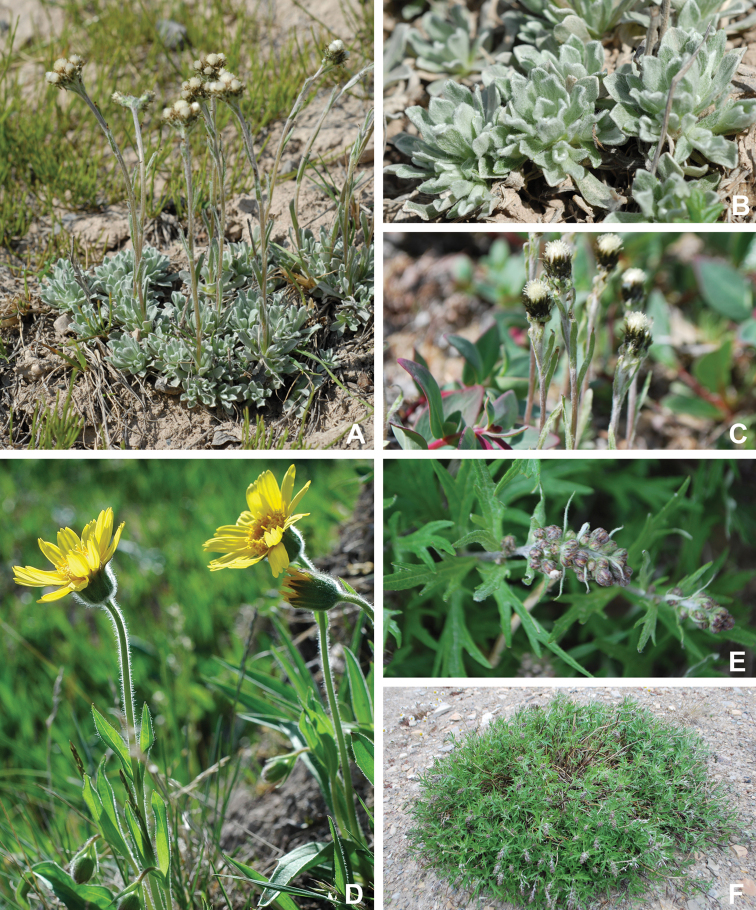
AAntennaria
media
subsp.
compacta habit, Gillespie et al. 9622BAntennaria
media
subsp.
compacta basal rosettes, Gillespie et al. 9622CAntennaria
monocephala
subsp.
angustata inflorescences DArnica
angustifolia
subsp.
angustifolia habit, Gillespie et al. 9607EArtemisia
tilesii inflorescence FArtemisia
tilesii habit. Photos A, B by L.J. Gillespie C, E, F by B.A. Bennett and D by R.D. Bull.